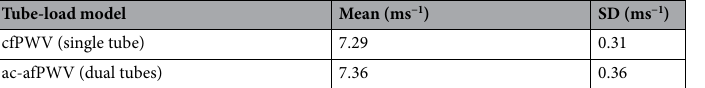
Table 3. Comparison of the single and dual tube models using the 1D model data. The central aortic pressure waveform of a single subject served as the input for running the simulation of the 1D model. The 41 groups of aortic, carotid and femoral pressure waveforms generated by changing the model parameters within the physiological range were used for calculating the means and SDs of PWV.